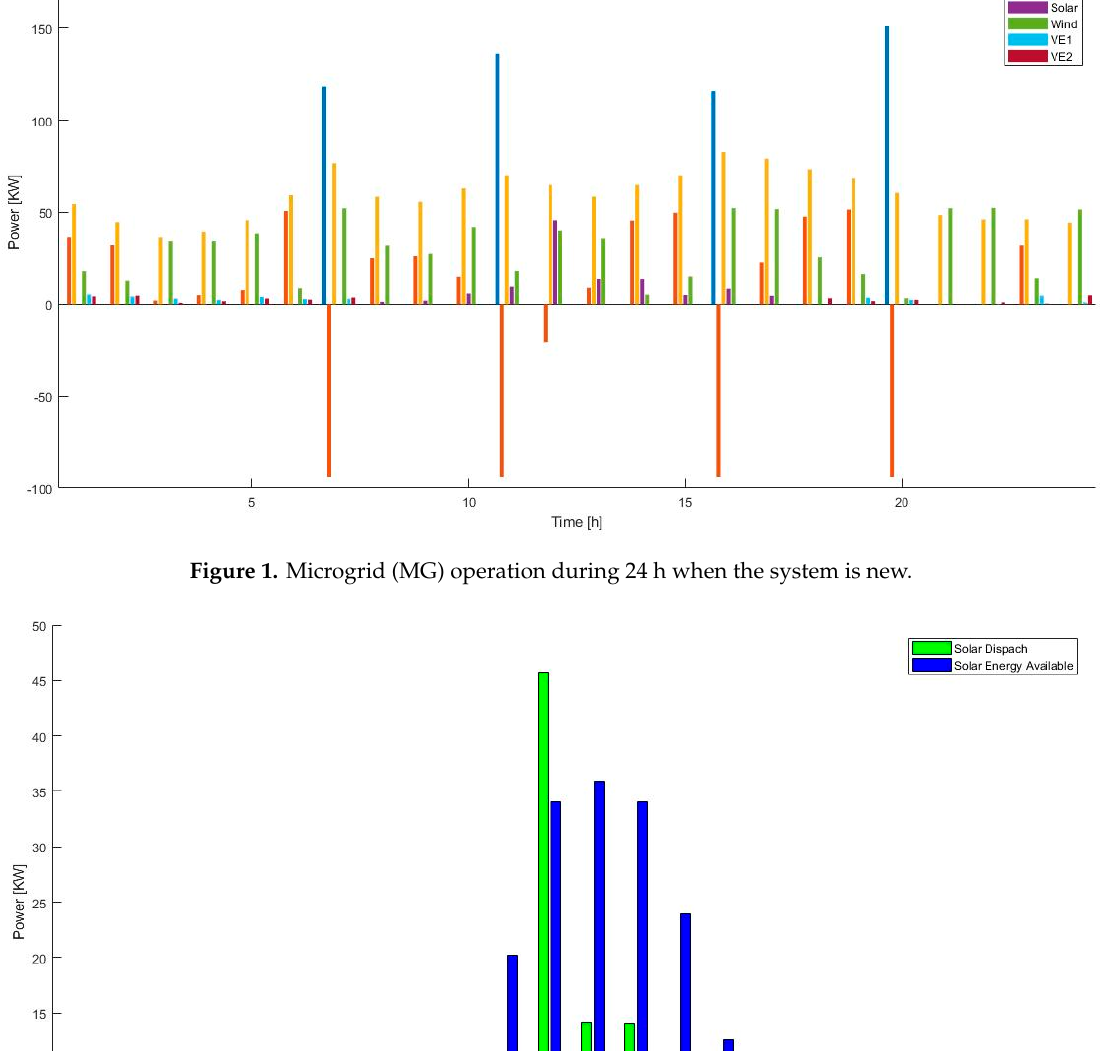
Figure 3. Wind power dispatched (green) vs. most probable power (blue) during the 24h of the day. Figure 4 shows the periods when the two aggregators of electric vehicles are charged. As it was expected, the aggregators take advantage of the periods of time when the energy cost is lower (10 pm–6 am) and in the periods when it is more expensive (2–10 pm). The full load of electric vehicles is guaranteed once the time horizon is finished and the vehicle leaves the power socket.